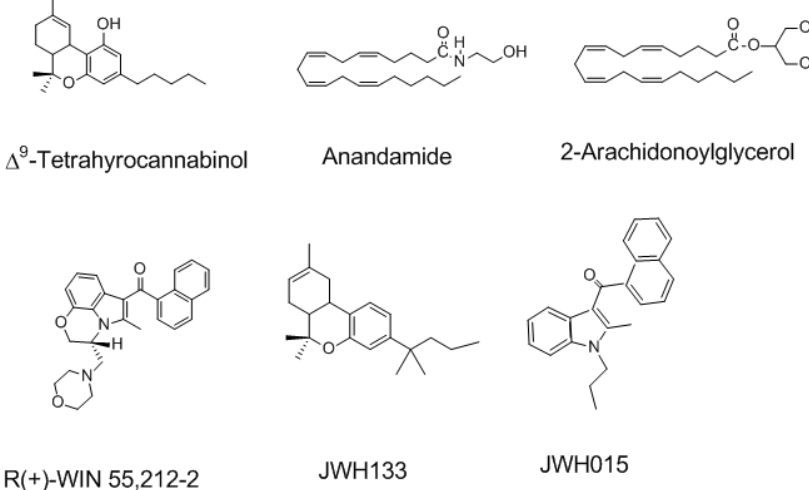
Figure 2. The structure of natural, endogenous and selective synthetic cannabinoid agonists of Cannabinoid receptors type 1 and type 2 (CB1R and CB2R).